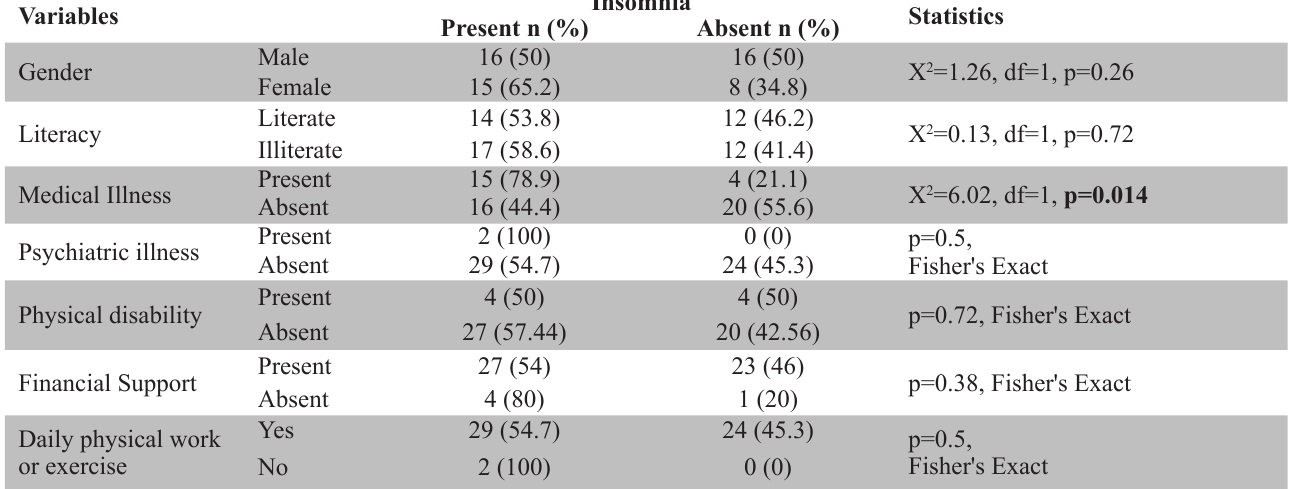
(N=55).Table Table 2. Clinical characteristics of the study population Table 3. Relationship between socio-demographic and clinical variables and insomnia